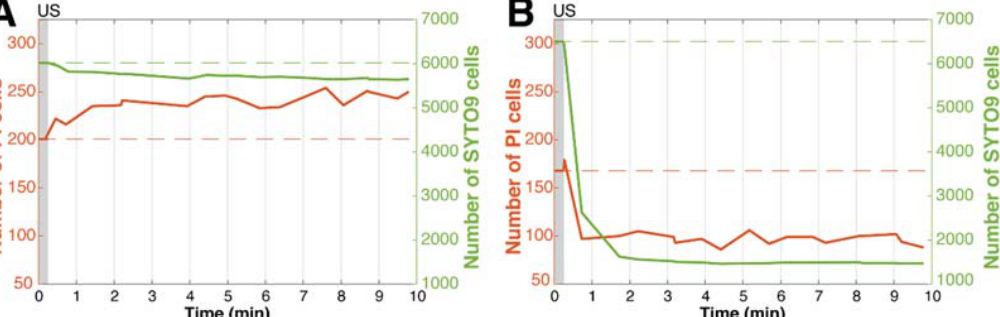
Figure 4. Different rates of dispersion and sonoporation of bacteria within biofilms. Example time- lapse line graphs during and after ultrasound with microbubbles treatment indicating ( A ) minimal dispersion and increasing propidium iodide uptake (ultrasound: 2 MHz, 200 kPa, 100 cycles, PRF 1 Hz, 30 s), corresponding to Figure 2, and ( B ) high dispersion with minimal propidium iodide uptake (ultrasound: 2 MHz, 400 kPa, 100 cycles, PRF 1 Hz, 30 s), corresponding to Figure 3. The grey bar at time point 0 indicates the 15 s before ultrasound insonification. (PI = propidium iodide; US = ultra- sound).